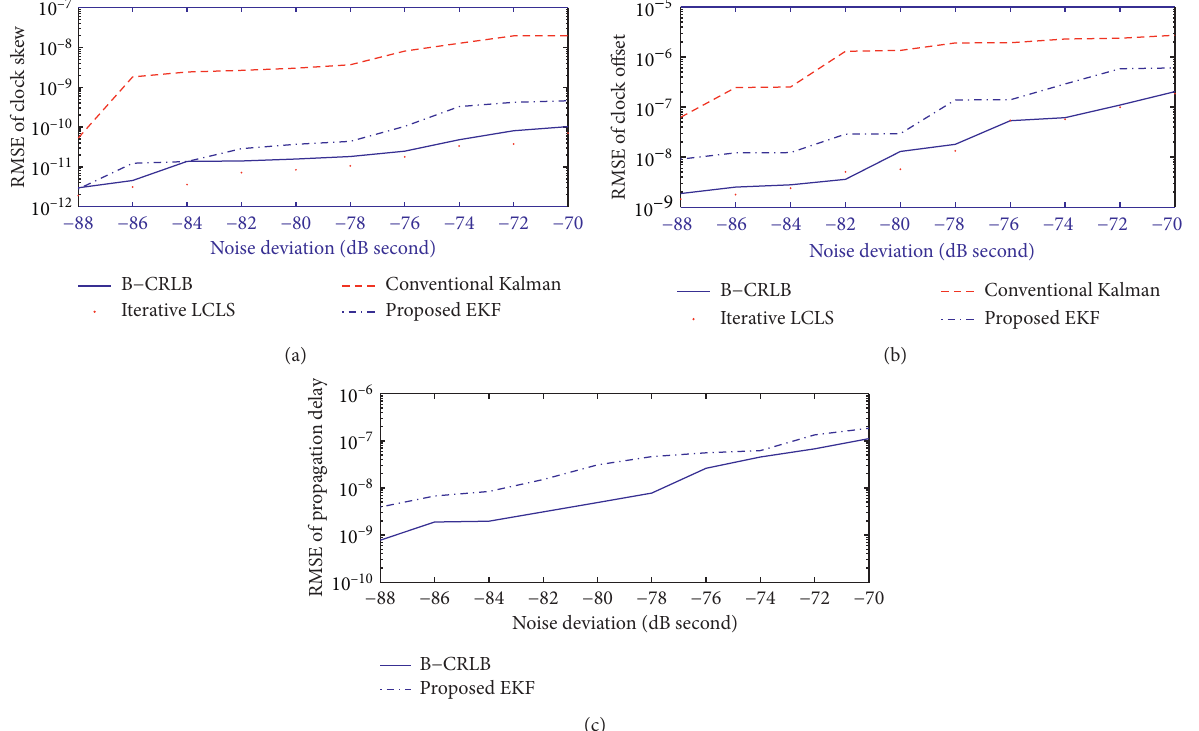
Figure 3: RMSEs of the estimated clock skew ω j (a), offset ϕ j (b), and propagation delay τ i,j (c) with respect to the varying noise